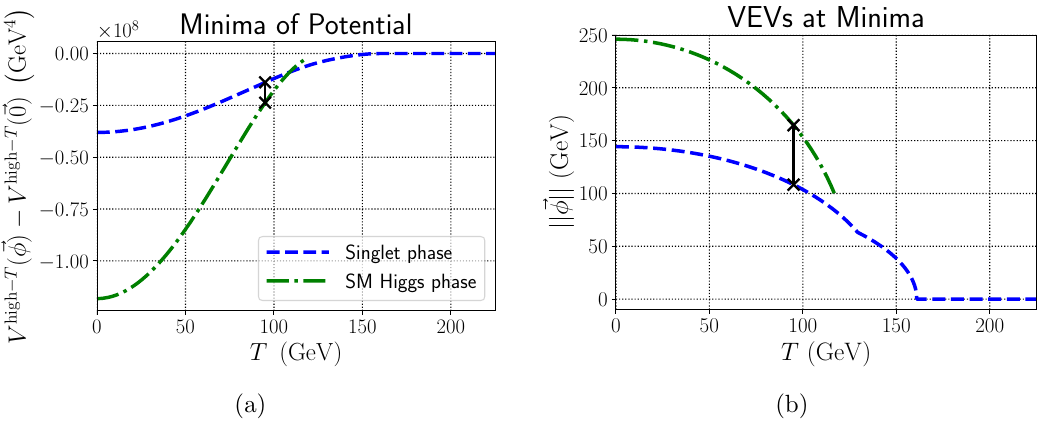
Figure 4. Phase transition results for benchmark point A showing, as a function of temperature: (a) relative depth of minima of potential, and (b) distance of minima from the origin. The crosses and black lines indicate the nucleation